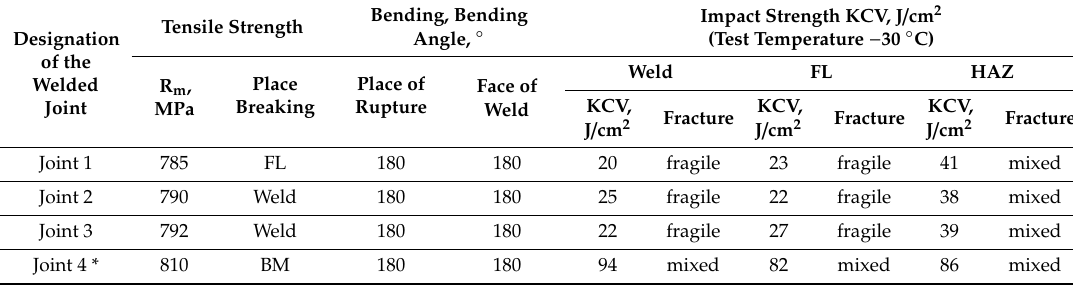
Table 4. Strength and ductility of the S700MC steel laser beam welded joints.